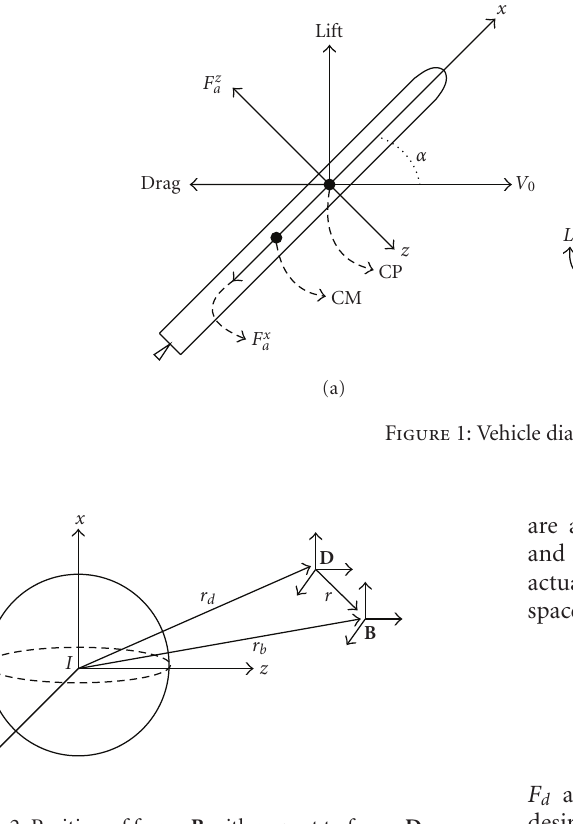
Figure 2: Position of frame B with respect to frame D